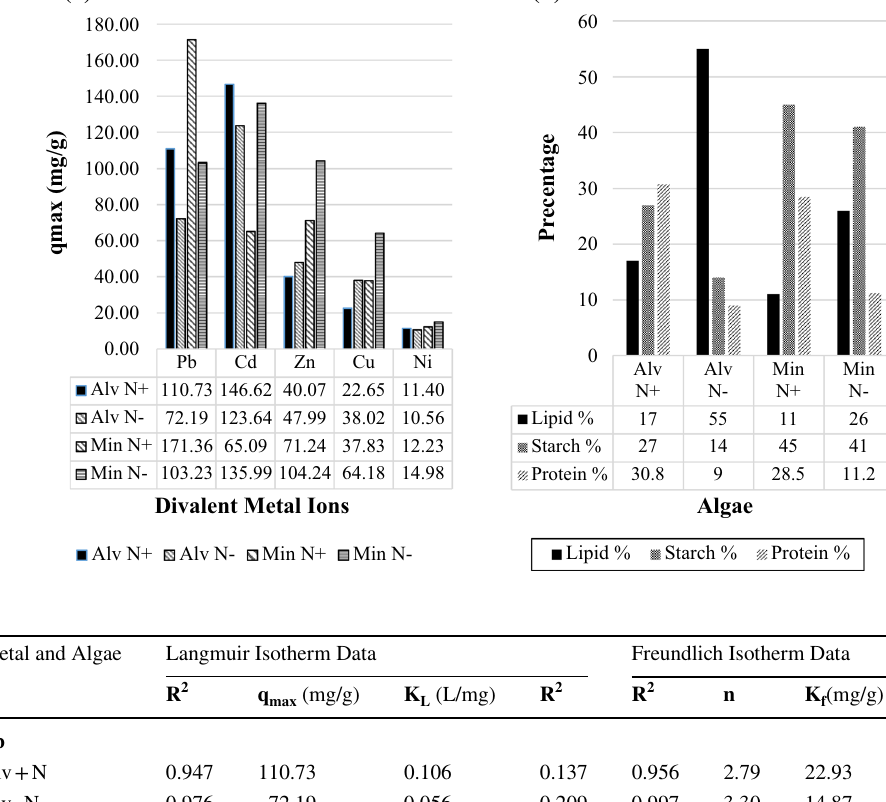
Table 3 The Langmuir and Freundlich isotherm data for five heavy metals tested with each algae: Neochloris alveolaris + N ( Alv + N), Neochloris alveolaris -N ( Alv -N), Neochloris minuta + N ( Min + N), and Neochloris minuta -N ( Min -N)